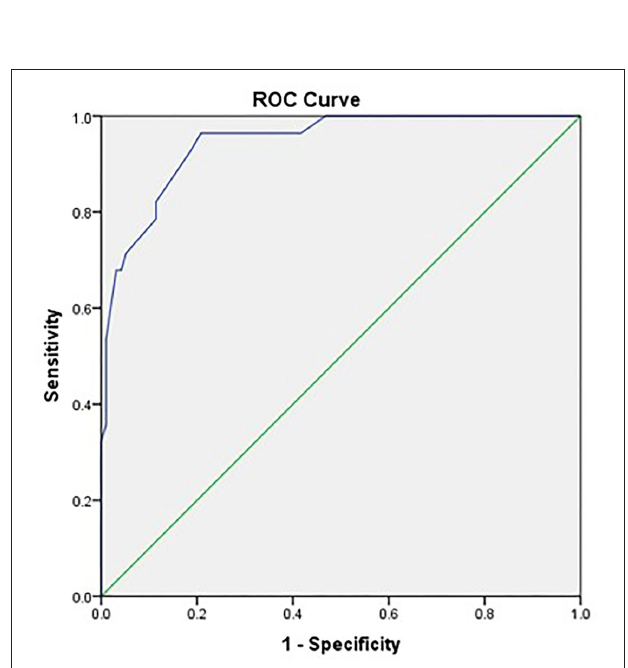
FIGURE 3 | The receiver operating characteristic curve for tumor size cutoff to predict the use of open surgery rather than non-open surgical approaches (robotic or laparoscopic). Area under the curve is 0.94 (95% confidence interval: 0.902–0.986), p =